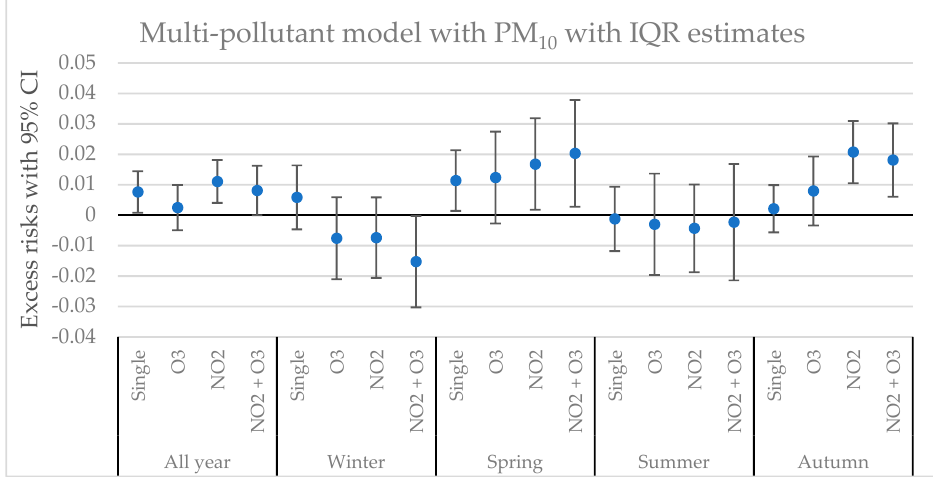
Figure 2. Estimated excess risks in daily mortality with 95% CI (lag02) for an IQR increase in the concentrations of PM 10 . The calculations are divided into all year and four different seasons. The excess risks are presented as single ‐ pollutant estimates and multi ‐ pollutant estimates with O 3 , NO 2 and NO 2 + O 3 included in the calculations.